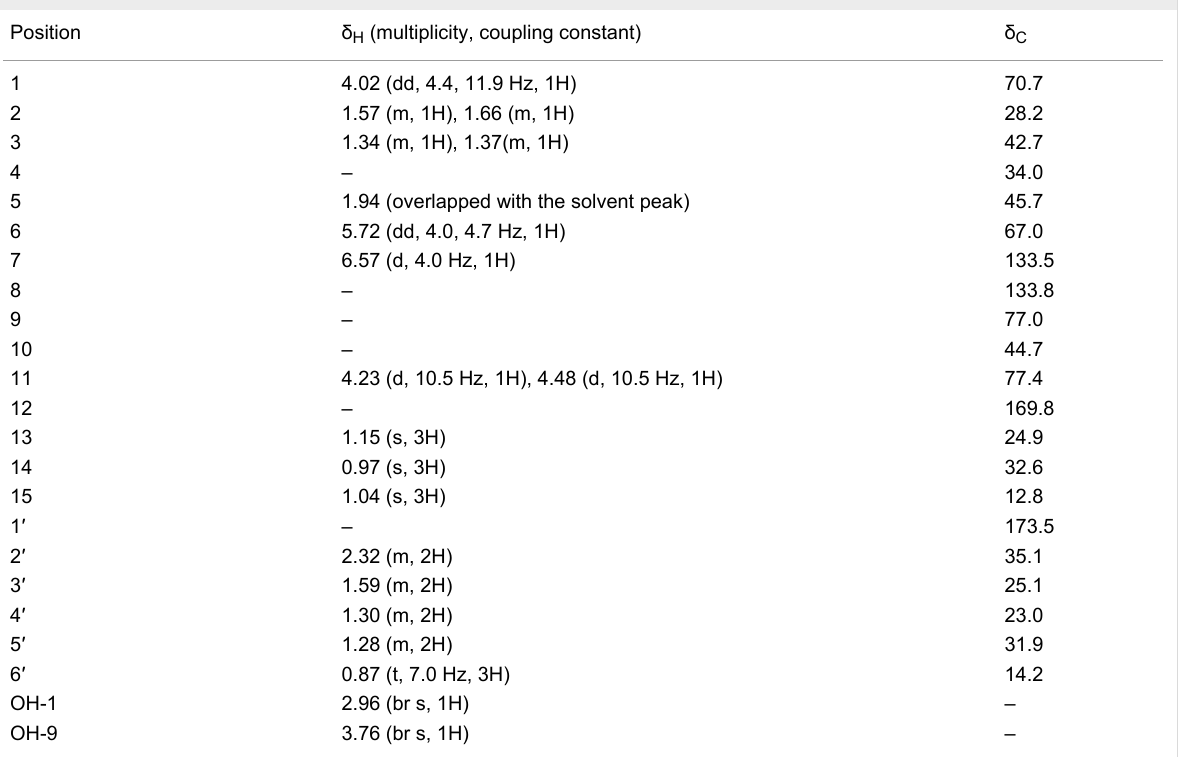
Table 1: 1 H (600 MHz) and 13 C NMR (150 MHz) data of SF002-96-1 in CD 3 CN.